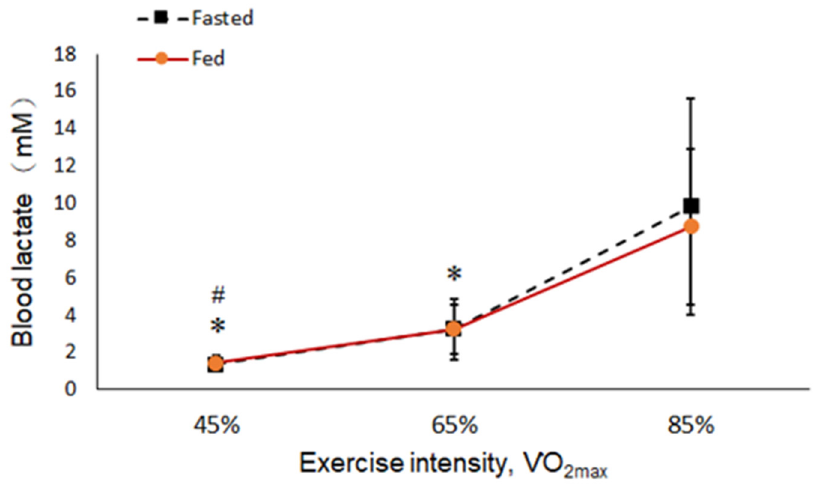
Figure 6. Blood lactate (BLA) at each intensity in the fed and fasted state. “*”: Significant difference compared to 85% VO 2max at 65% and 45% VO 2max in the same state ( p < 0.05). “#”: Significant difference compared to 65% VO 2max at 45% VO 2max in the same state ( p < 0.05).